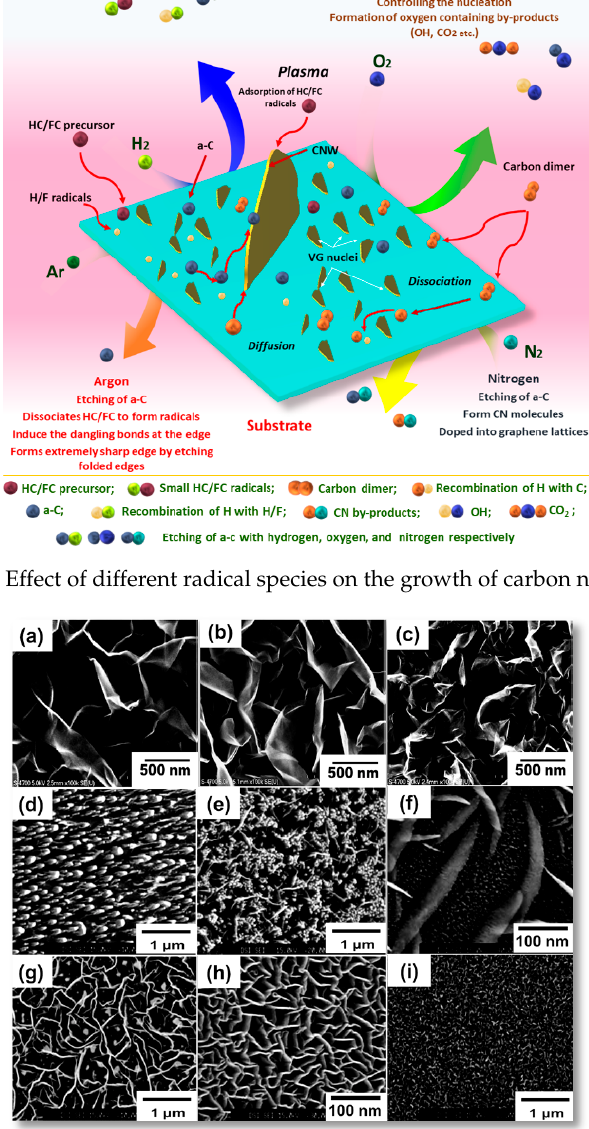
Figure 5. SEM images of graphene nanowalls (GNWs) with different CH 4 concentration ( a ) 10%, ( b ) 40%, ( c ) 100%. Reprinted with permission from the authors of [84]. Copyright Elsevier 2004. SEM images of carbon grown at different H 2 /CH 4 flow rate ratios: ( d ) 30, ( e ) 15, ( f ) 10, ( g ) 6, ( h ) 4, ( i ) 1 sccm. Reproduced with permission from [85]. Copyright Royal Society of Chemistry 2004.